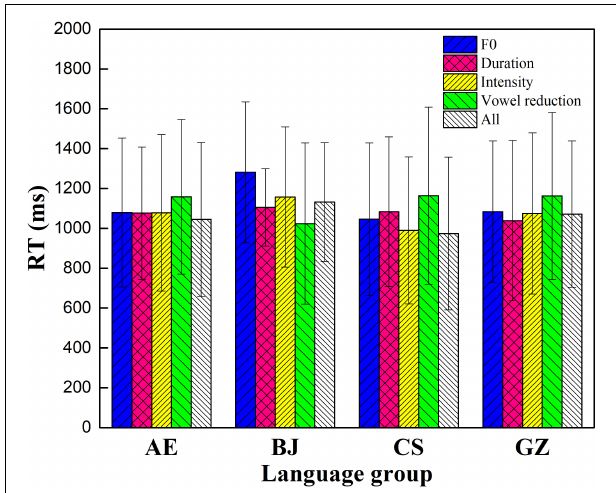
FIGURE 9 | Participant RT for the five